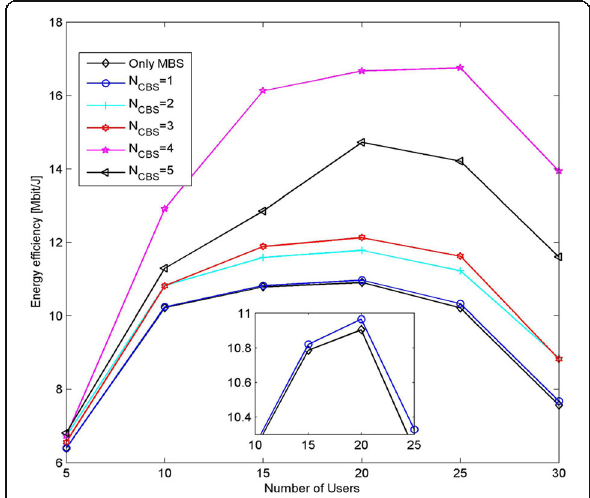
Fig. 8 EE with respect to N BS for different coordination schemes. ◇ represents there is only macro base station that the number of small base station N CBS = 0 . о represents the number of small base station N CBS = 1 . + represents the number of small base station N CBS = 2 . * represents the number of small base station N CBS = 3 . ☆ represents the number of small base station N CBS = 4 .